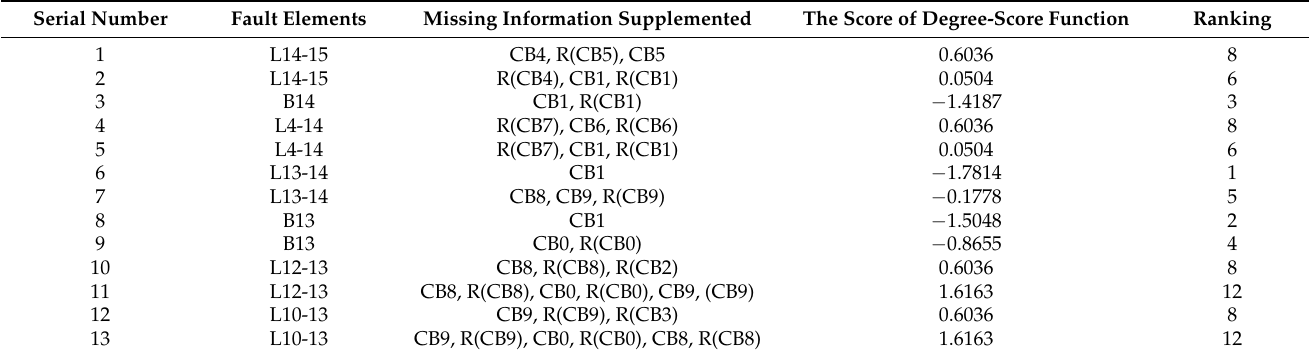
Table 7. Results sorted with DFTS.